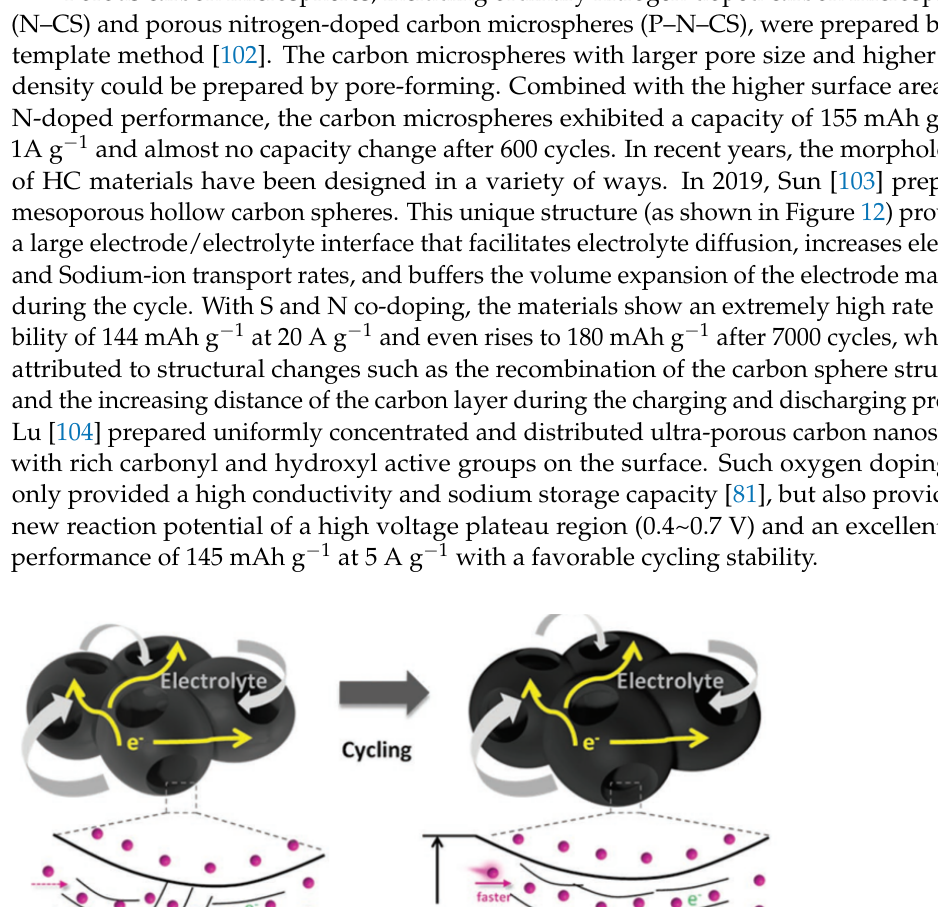
Figure 13. ( a ) SEM image of carbon source cotton. ( b ) The magnified SEM images of the carbonized cotton with a clear and visible hollow structure [49]. Furthermore, Yuan [105] synthesized flower-like nitrogen-doped hierarchical po- rous carbon networks (NHPCN) by using the self-template method and a single precur- sor. It has a high-level spaced graphite layer, ultra-thin two-dimensional nanostructure,